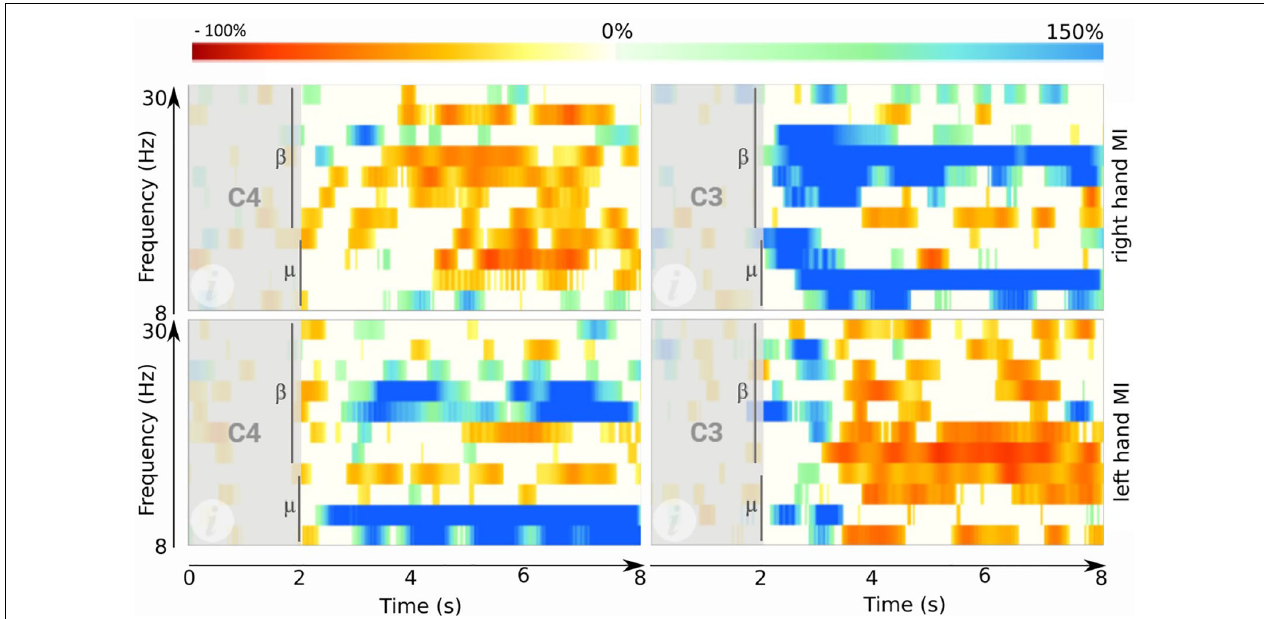
FIGURE 2 | ERD maps obtained after one session of BCI training. Top right: ERD map during right hand MI on site C3. Top left: ERD map during right hand MI on C4. Bottom right: ERD map during left hand MI on C3. Bottom left: ERD map during left hand MI on C4. Each plot shows the time from 0 to 8 s ( x -axis) and frequencies between 8 and 30 Hz ( y -axis). Red areas indicate high ERD. Blue areas mark the opposite: an ERS. Vertical bars indicate the cue onset at 2